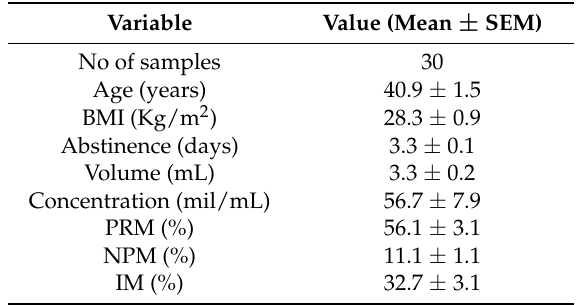
Table 2. Mean ± SEM values of sperm parameters studied in both control and glyphosate-treated samples after 1 h of treatment.